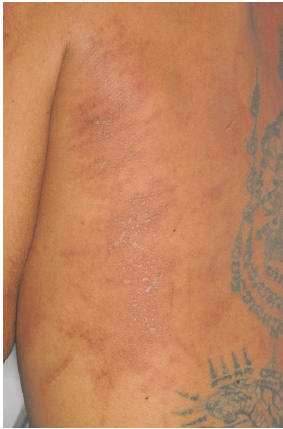
Figure 1: Linear, dermographism-like, and vague lichenoid